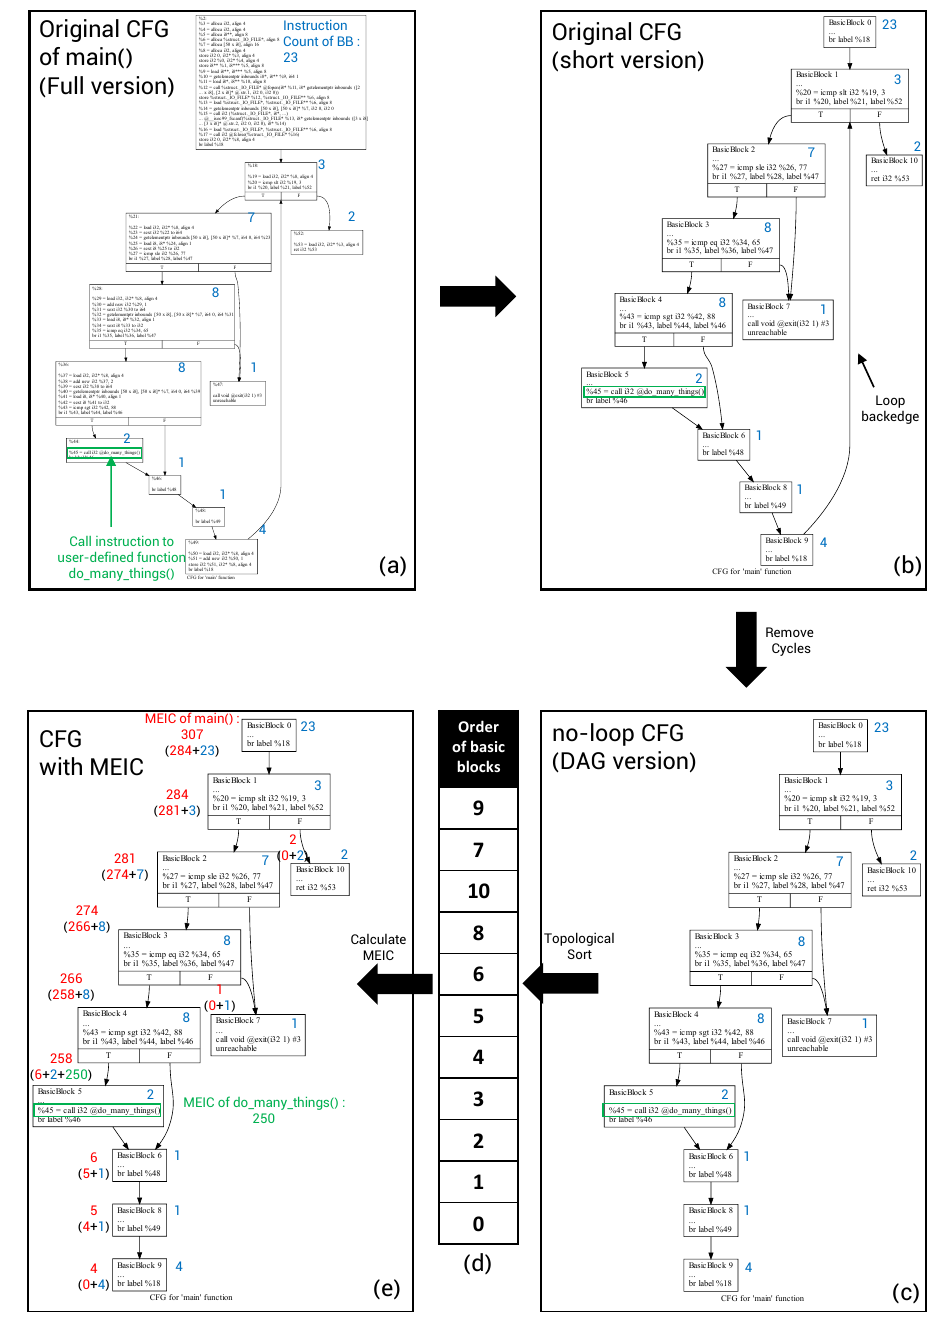
Figure 5. The overall process for calculating MEIC of main() function in motivating example. ( a ) Original CFG of main() (full version); ( b ) Original CFG (short version); ( c ) no-loop CFG (DAG version); ( d ) Order of basic blocks; ( e ) CFG with